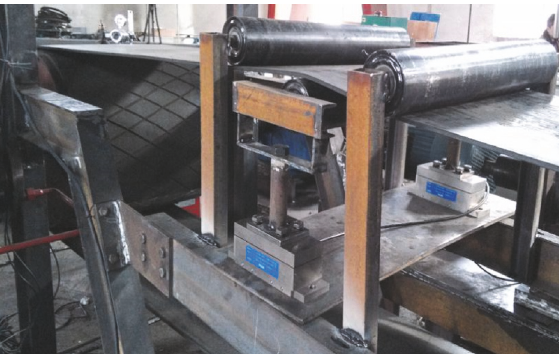
Figure 16: The site map of tension